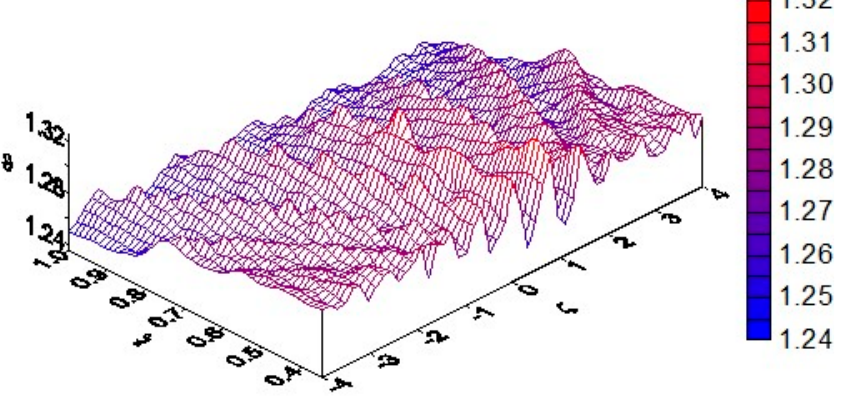
field here is highly heterogeneous. The frequent oscillation in the amplitude of the function of the screw.